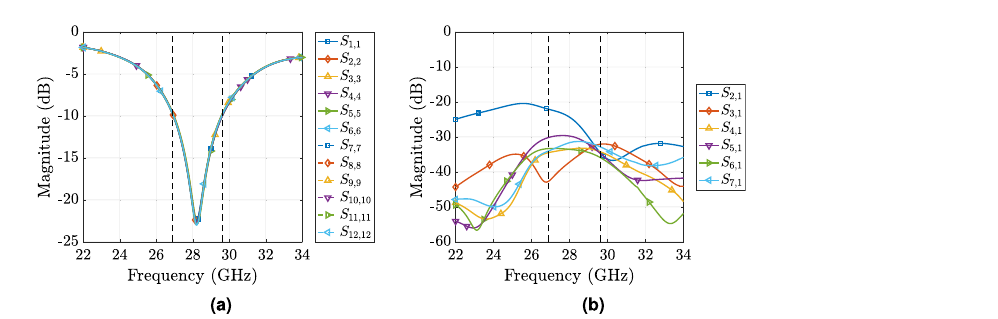
Figure 2. Simulated far-field radiation pattern of a single antenna element, which lays in the zy -plane versus polar (i.e., θ ) and azimuthal (i.e., φ ) angle: E θ ( a ) and E φ ( b ) denotes the electric field component in the θ and φ direction. E θ component, which is vertical to the horizontal plane (i.e., xy -plane), is maximized at θ = 90 ◦ and φ = 0 ◦ , thus, in the horizontal plane and specifically in front of the single antenna element: this component will lead to multimode operation in the circular antenna array geometry. E φ component, which is tangential to the horizontal plane, is maximized at θ = 0 ◦ , thus, in the vertical direction and specifically at the top of the single antenna element: this component will lead to the form of OAM-modes in the circular antenna array. Also, please note that where E φ is maximized, E θ is minimized, and vice-versa. The latter is the key-point that makes the proposed circular antenna bi-functional.